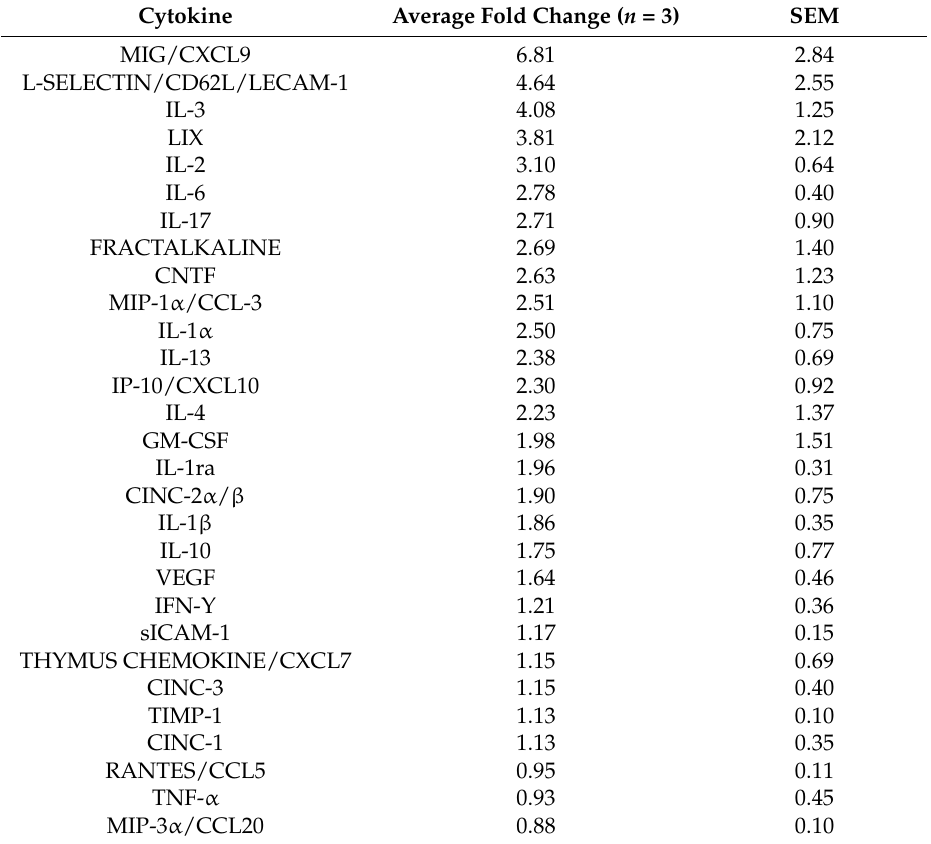
Table 1. Average fold change in the level of cytokines release in glial rich cell culture after exposure to CGRP compared to control